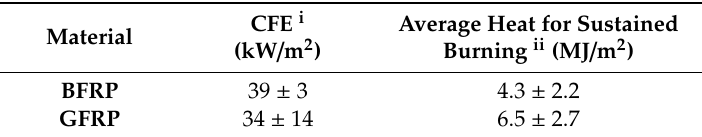
Table 1. Results of the spread of flame testing.